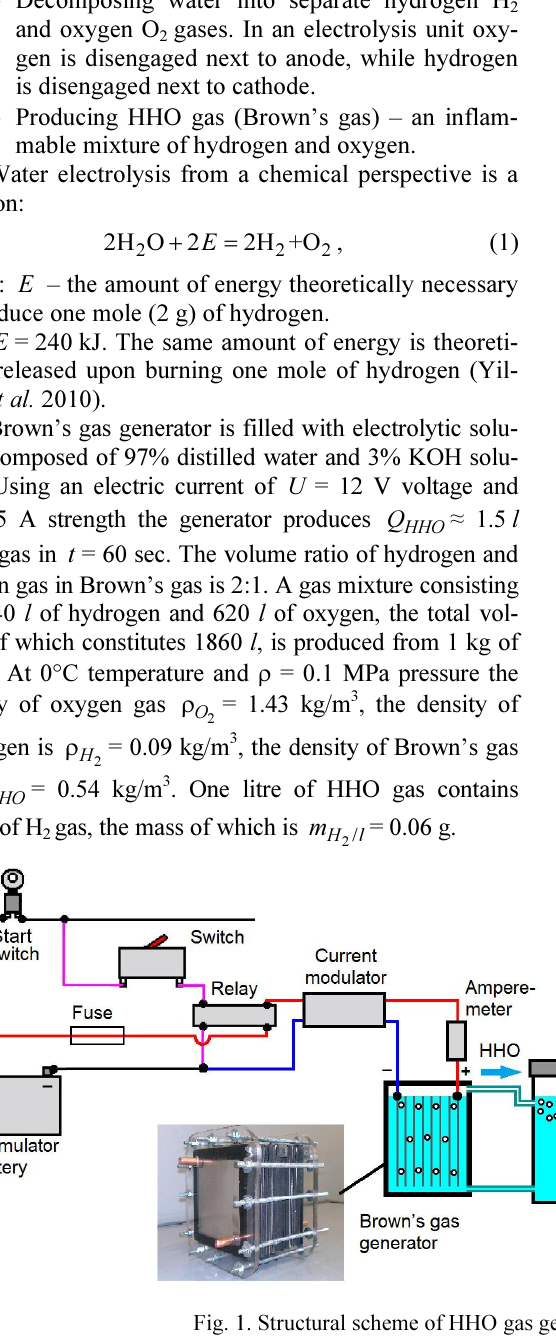
Fig. 1. Structural scheme of HHO gas generator installation in an